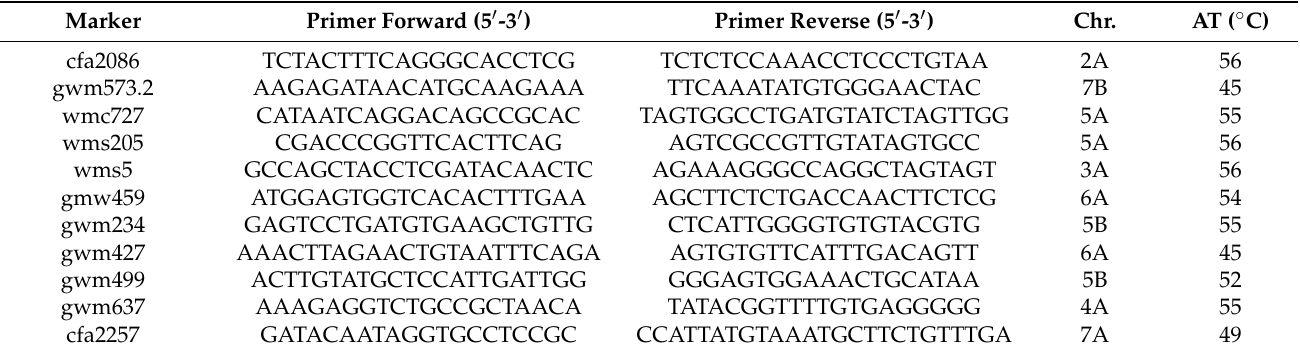
Table 6. Primers used for PCR